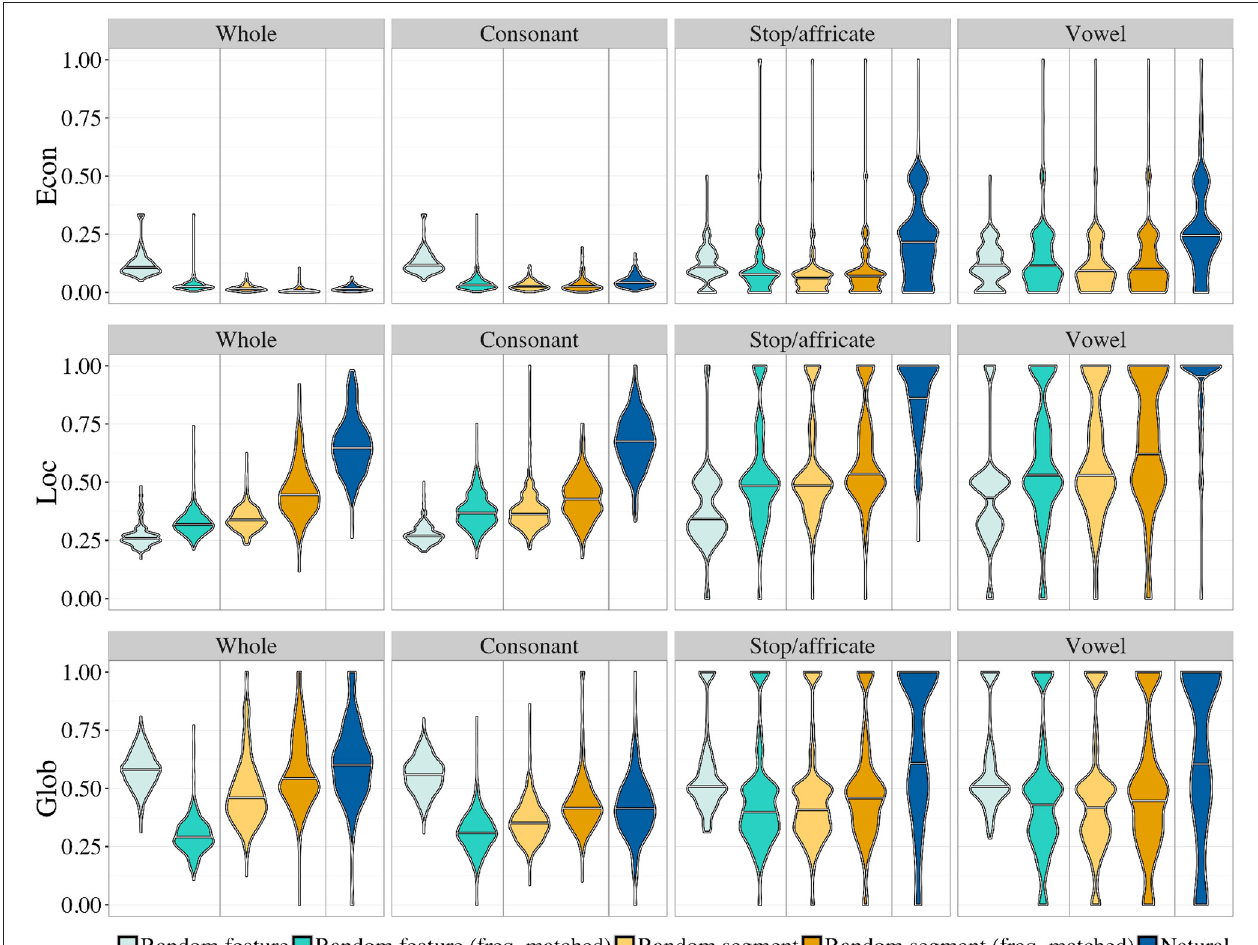
FIGURE 6 | Smoothed density plots for the three geometric properties, comparing different random inventories (see text). The horizontal line is the smoothed median. Control (dark blue) and frequency-matched random segment (darker orange) inventories are the same as in Study 1